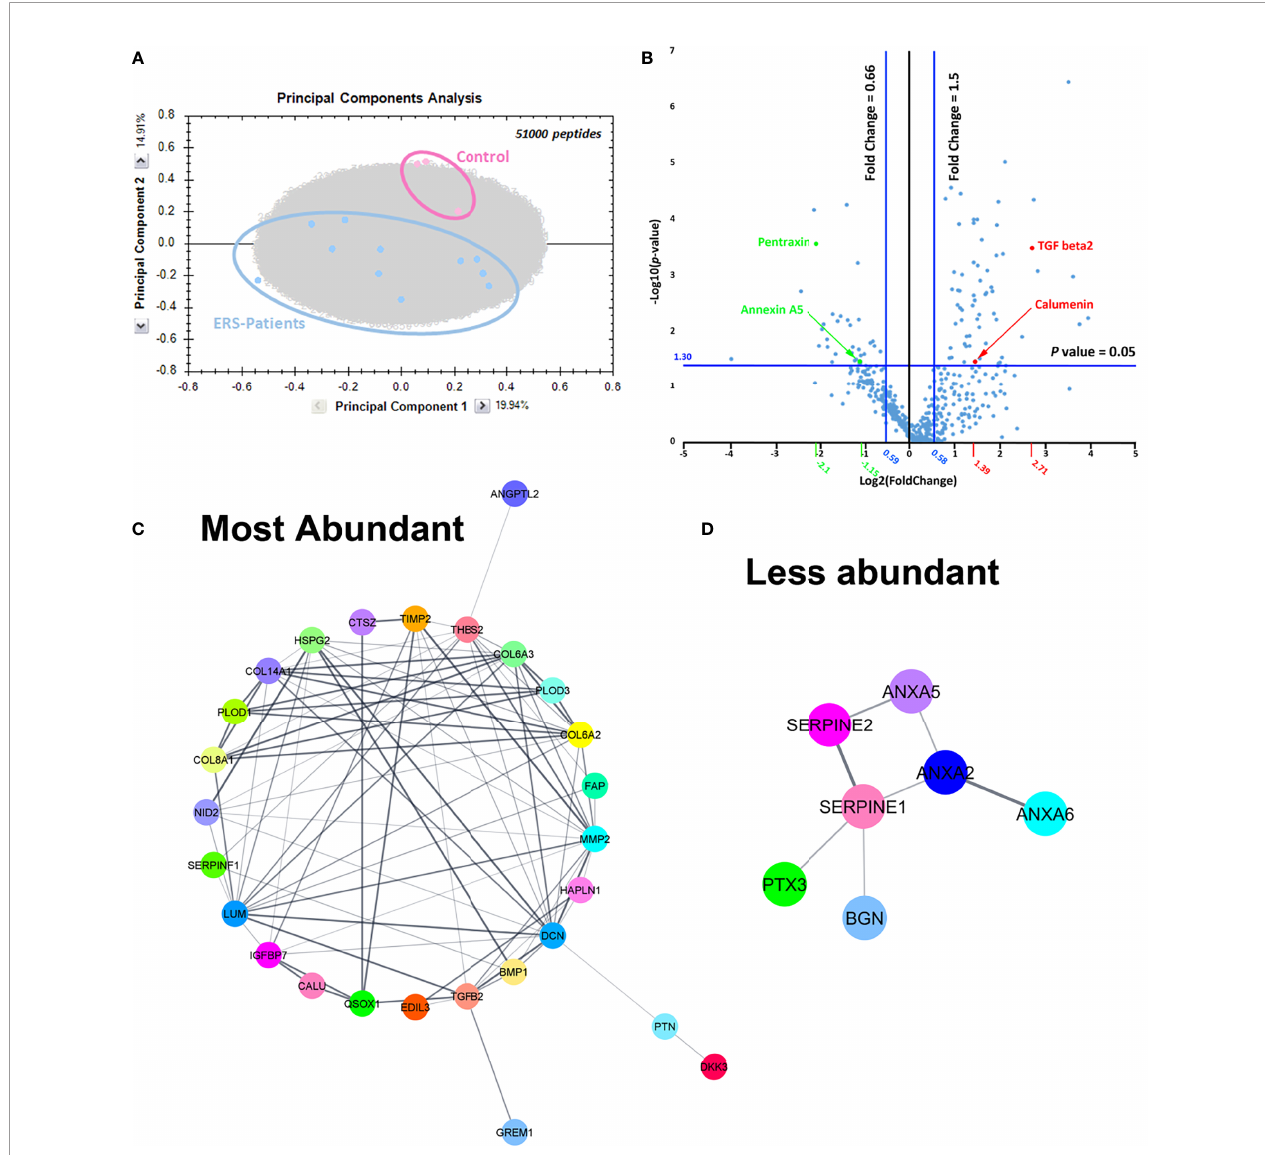
FIGURE 2 | (A) Principal component analysis plot including all peptides con fi dently annotated from MS data, that belong to all proteins identi fi ed in controls and ERS patients secretomes. (B) Volcano plot representation plotting Log ( p -value) against Log (fold change). Here, p -values were obtained from t -test performed for all quanti fi ed proteins between Controls and ERS patients. In the right upper quarter, red dots represent examples of proteins that were more abundant in secretomes from ERS patients and green dots represent proteins with lower abundance in secretomes from ERS patients (upper left quarter). (C, D) Protein-protein association network using String analysis performed with the differentially secreted proteins, over-expressed (C) and under-expressed (D) in the ERS